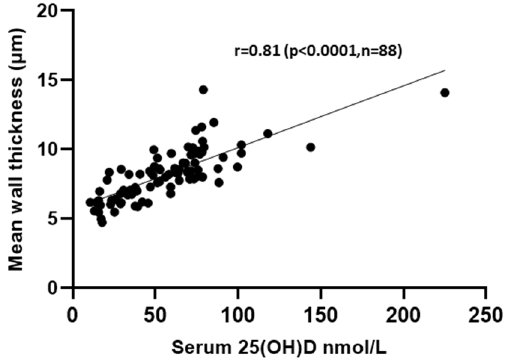
Figure A2. Representative femoral Anterior–Posterior plain radiograph indicating the measures of lateral cortical thickness (1), medial cortical thickness (2), M ‐ L medullary width (3) and femoral width (4).